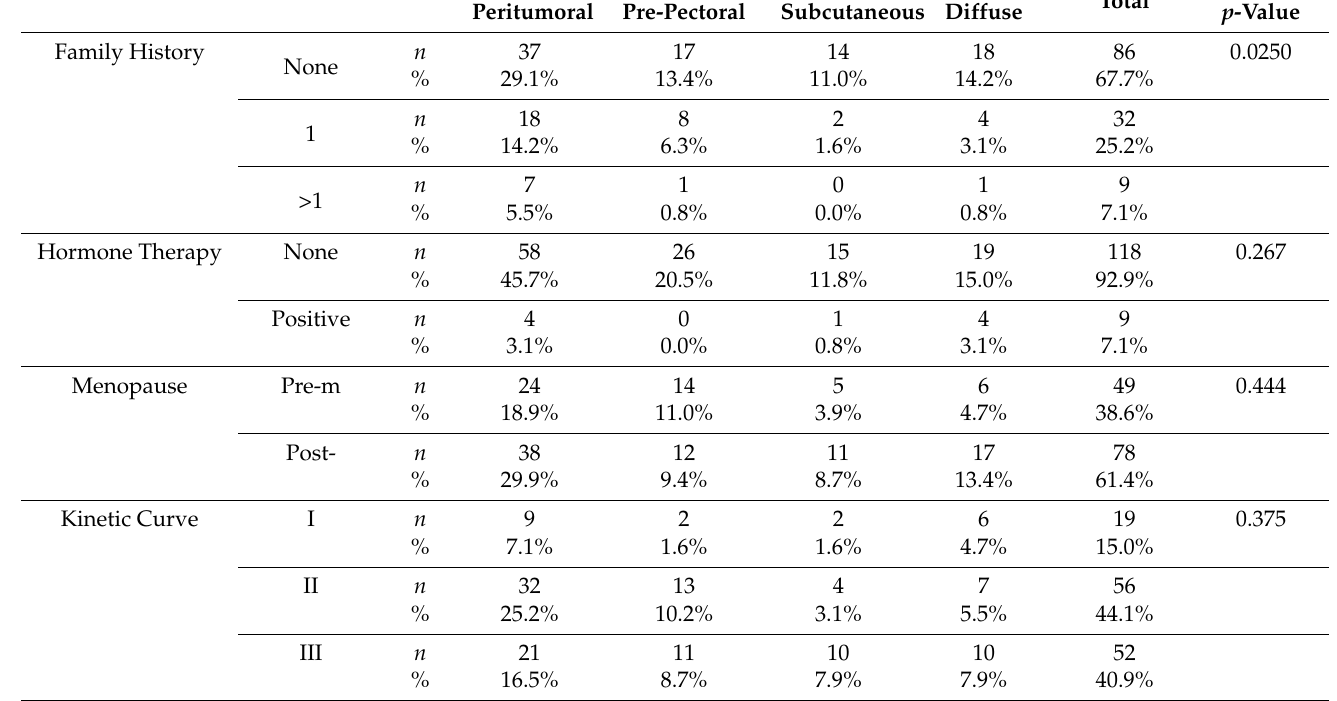
Table 2. Clinical, histologic, and MRI characteristics of the patients presenting with breast edema, classified according to the type of edema (* means the correlation is statistically significant). HT: hormone therapy, IDC: Invasive Ductal Carcinoma, ILC: Invasive Lobular Carcinoma, LNS: Lymph Node